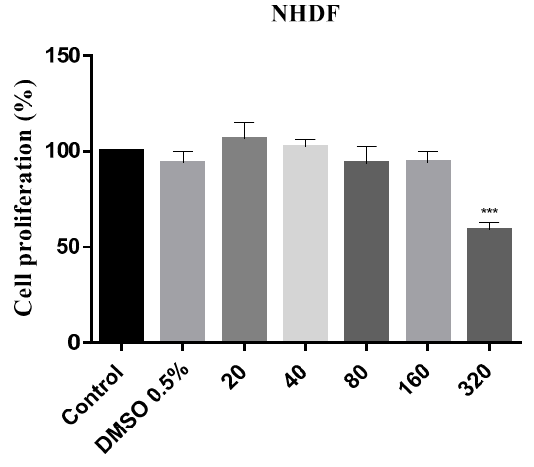
Figure 6. Antiproliferative effect of Ganoderma lucidum extract on SW 620, LOVO, and LOVO/DX after 72 h treatment. The results are the mean ± SD of three independent experiments. The significance of the differences was determined by Student’s t -test. * p < 0.05, ** p < 0.01, *** p < 0.001.